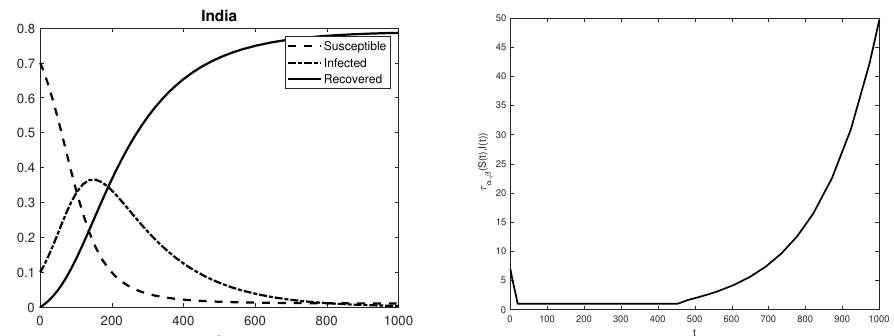
Figure 4. Solution to the SIR model (1), with initial value given by the vector (4), for India ( left ) and corresponding pattern of τ α , β ( S ( t ) , I ( t )) ( right ).